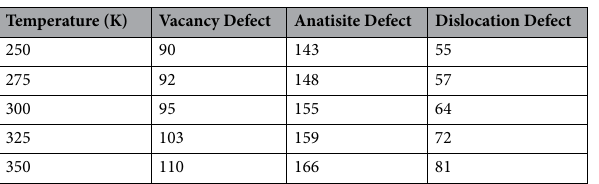
Table 6. Change in the number of involved atoms in vacancy, antisite, and dislocation defects at different temperatures.